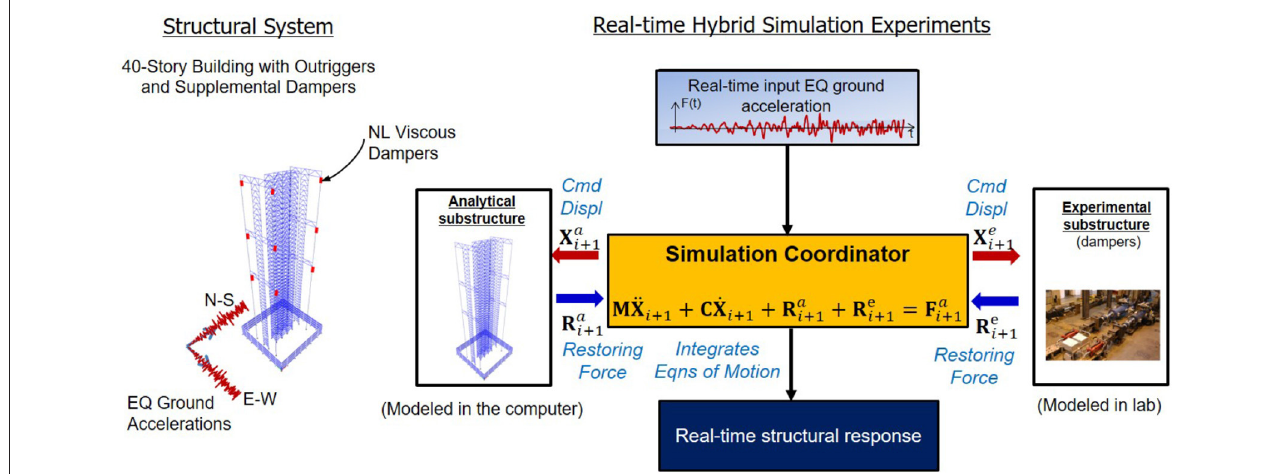
FIGURE 4 | Overall concept of real-time hybrid simulation: structural system subject to seismic ground motions.